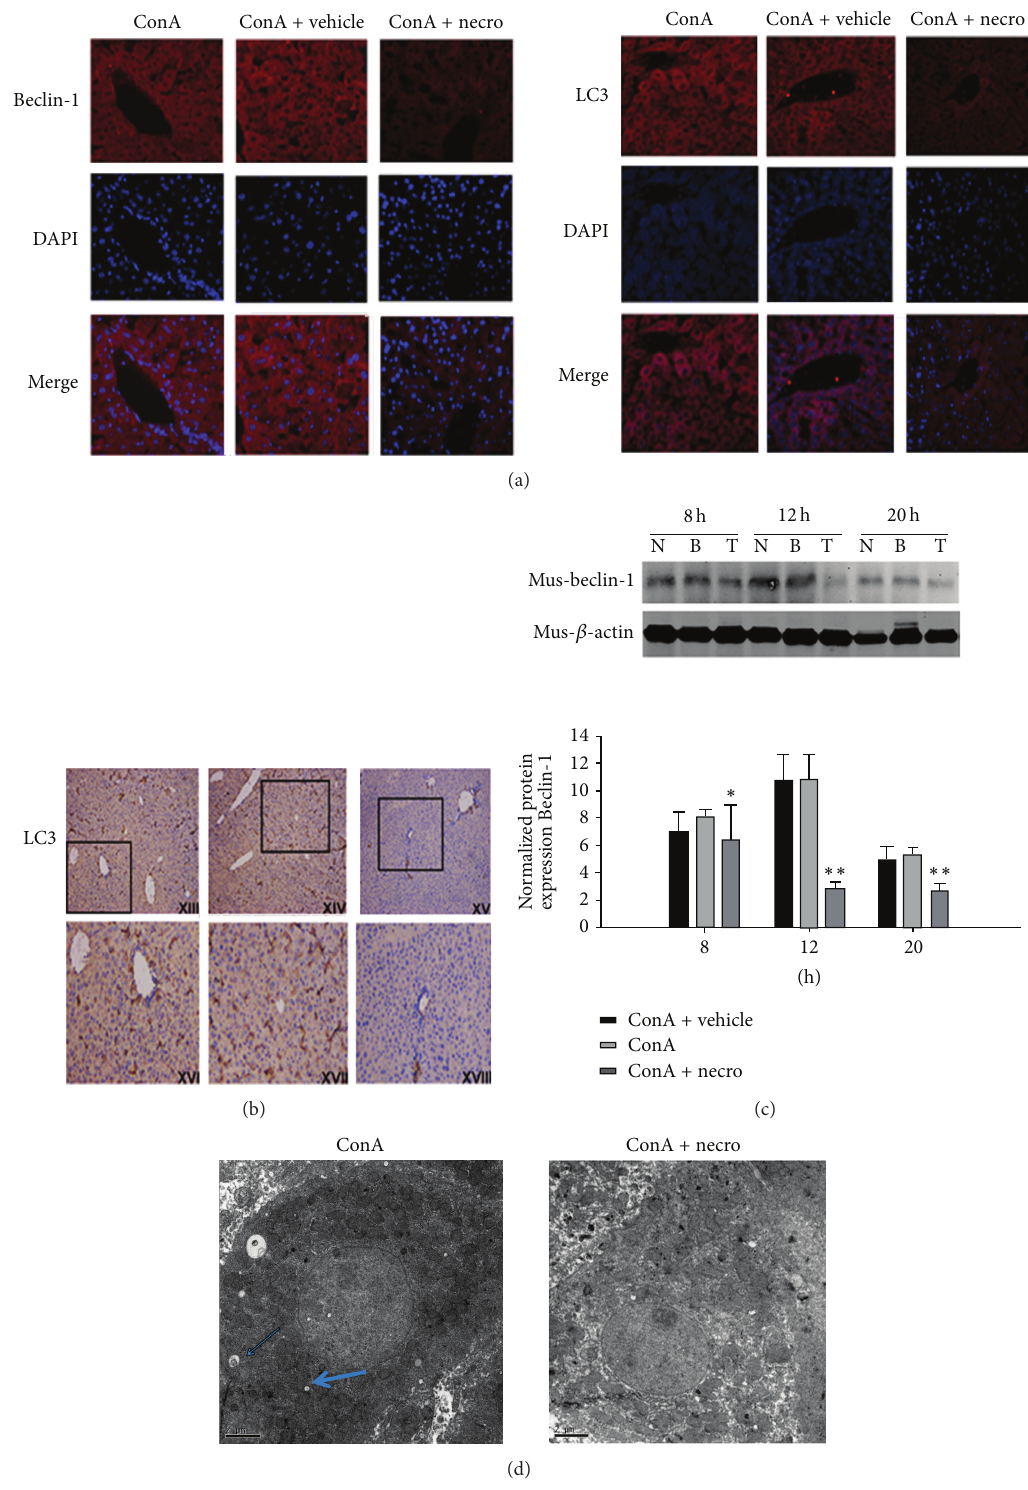
Figure 5: (a) Localization of beclin-1 and LC3 in liver tissues detected with immunofluorescence (original magnification × 200). (b) Immunohistochemical staining of LC3 after ConA-induced hepatitis in the control group, the vehicle-treated group, and the Nec-1-treated group. These experiments were repeated three times, and representative results are shown. The small image is × 200 magnification and the enlarged images show the framed parts of the small images ( × 400). (c) Effects of Nec-1 on ConA-induced hepatic beclin-1 protein expression. (d) Autophagosome formation induced with ConA is detected in hepatocytes with transmission electron microscopy and was significantly reduced by the Nec-1 intervention. Arrows indicate